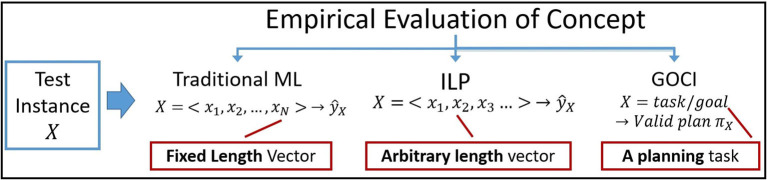
Difference in evaluation of a concept instance across different learning paradigms.